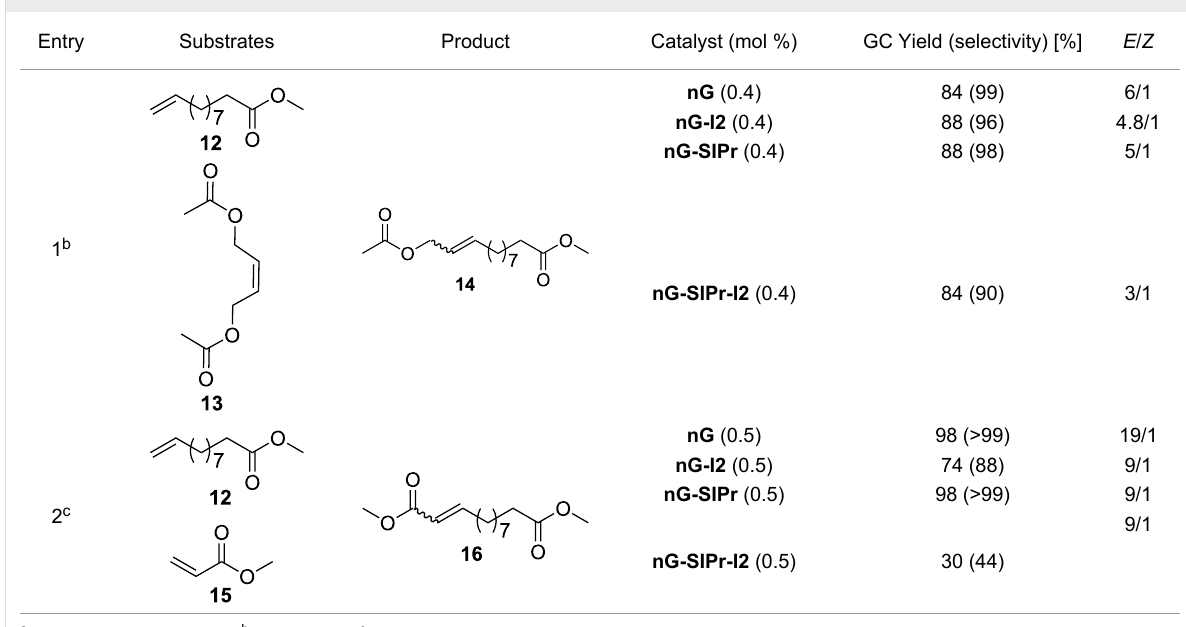
Table 2: Results of CM reactions.